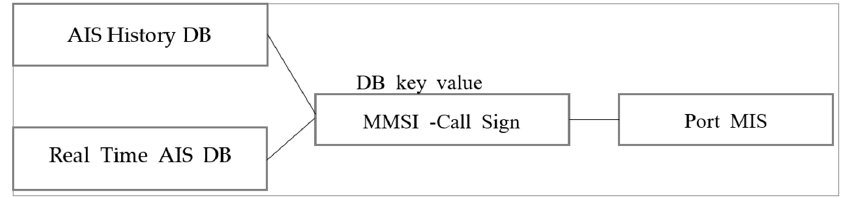
Figure 5. Database key between AIS database and Port MIS database.